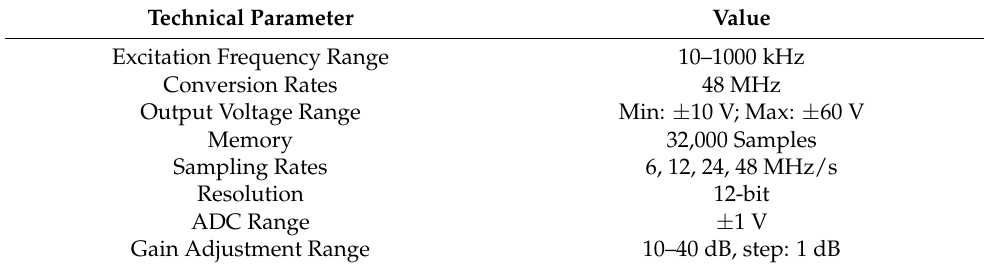
Figure 9. Data acquisition devices. Table 1. Monitoring equipment technical